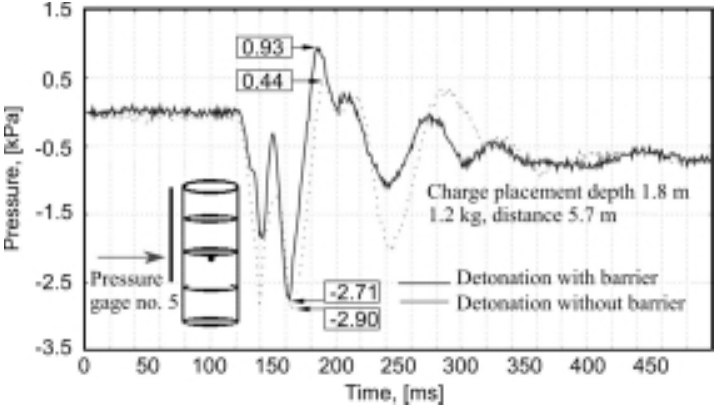
Fig. 19. Time histories of pressures p h acting on a structure side, measured by gage No. 5 from a detonation at 5.7 m from the silo. which is below of the barrier. Significantly smaller pressure attenuation were obtained in the case screened gage placed on depth z = 1.80